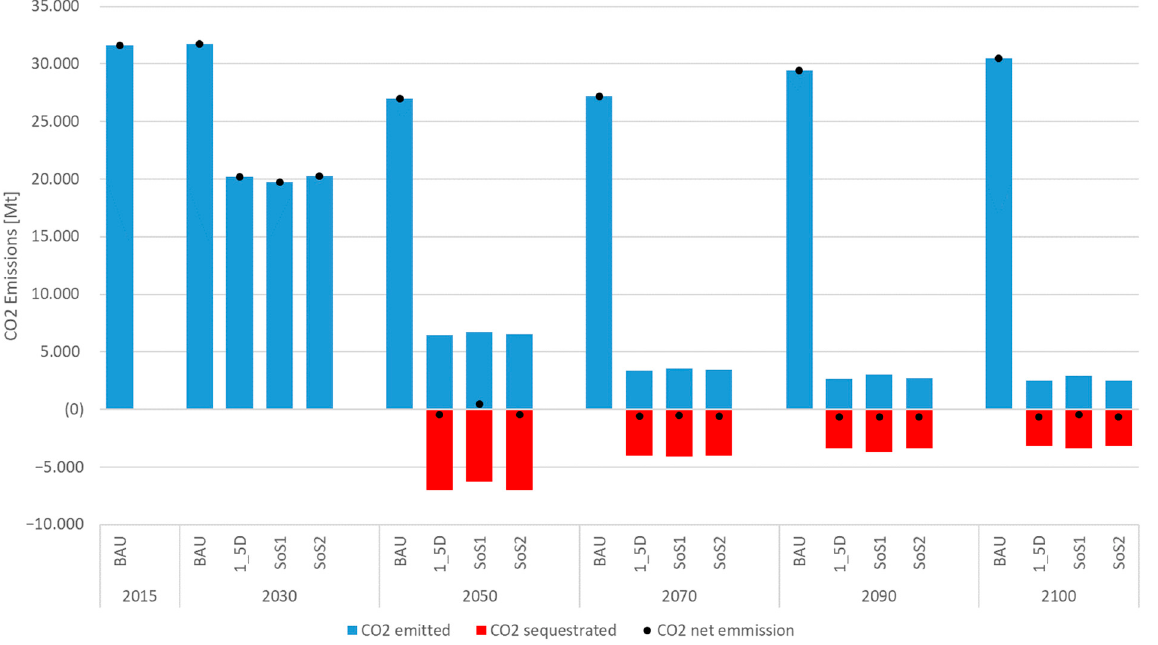
Figure 4. Global CO 2 emissions across all scenarios.